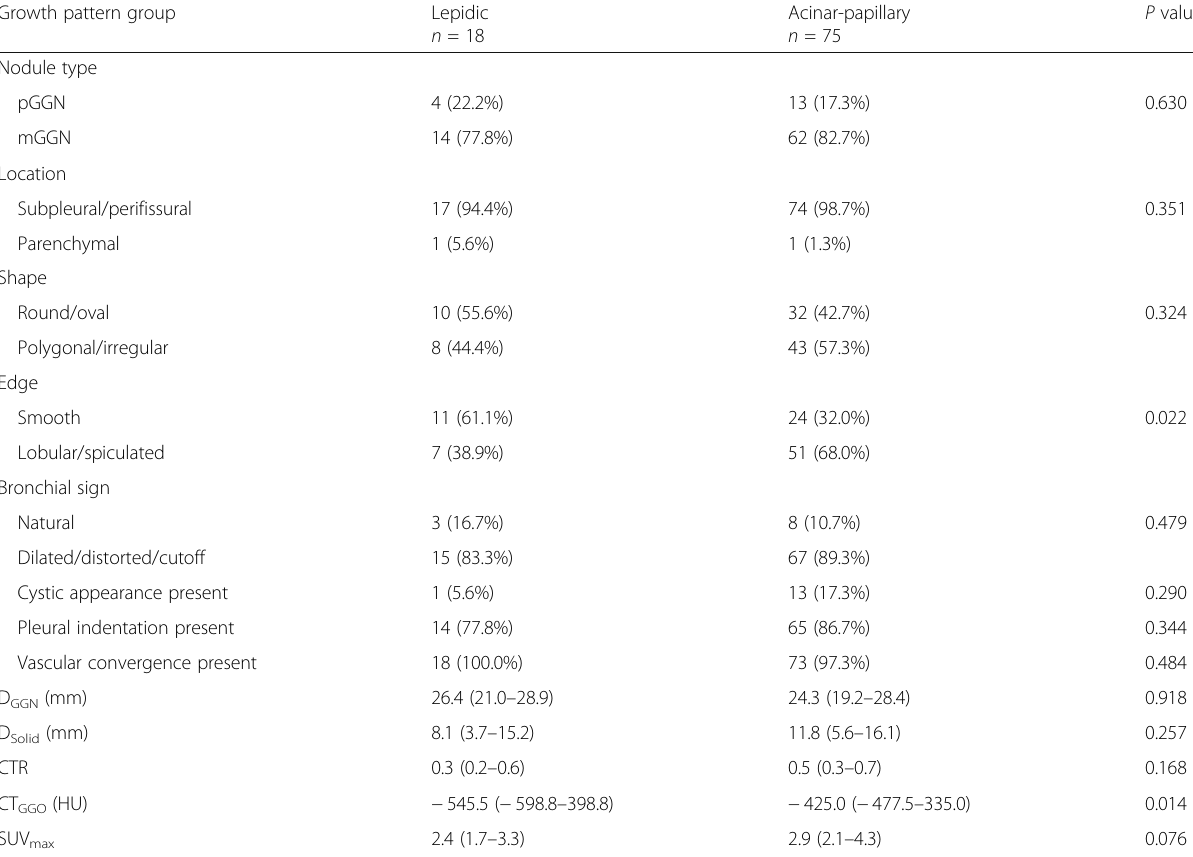
Table 1 Comparison of conventional PET/CT parameters between lepidic group and acinar-papillary group Growth pattern